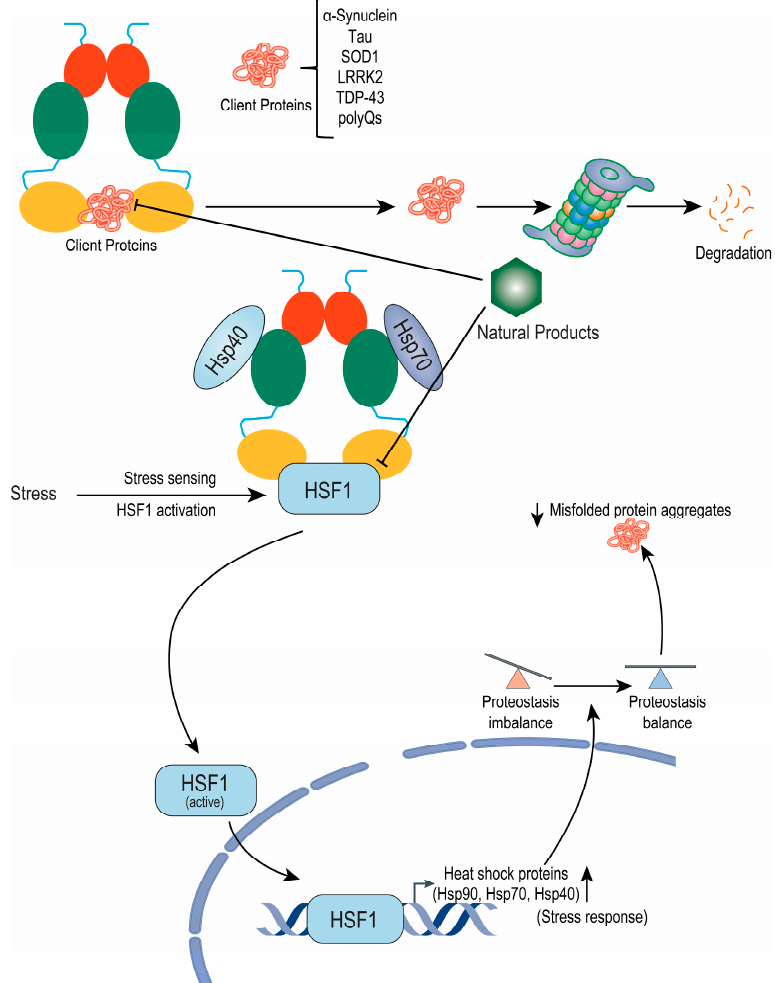
Figure 3. Molecular mechanism of Hsp90 inhibition by natural products in alleviating neurodegeneration. Hsp90 inhibition by natural products could initiate two different processes, resulting in the degradation of client protein (pathological misfolded protein) and improving proteostasis. Hsp90 inhibition causes the release of pathogenic “client” proteins for proteasomal degradation, where the interaction of Hsp90 provides structural stability and maintenance of these client proteins. The inhibition of Hsp90 also stimulates the upregulation of other heat shock proteins via an HSF1-dependent mechanism. These HSPs can improve cell survival in a “stressed” environment by facilitating the clearance and blocking the accumulation of abnormal clients.